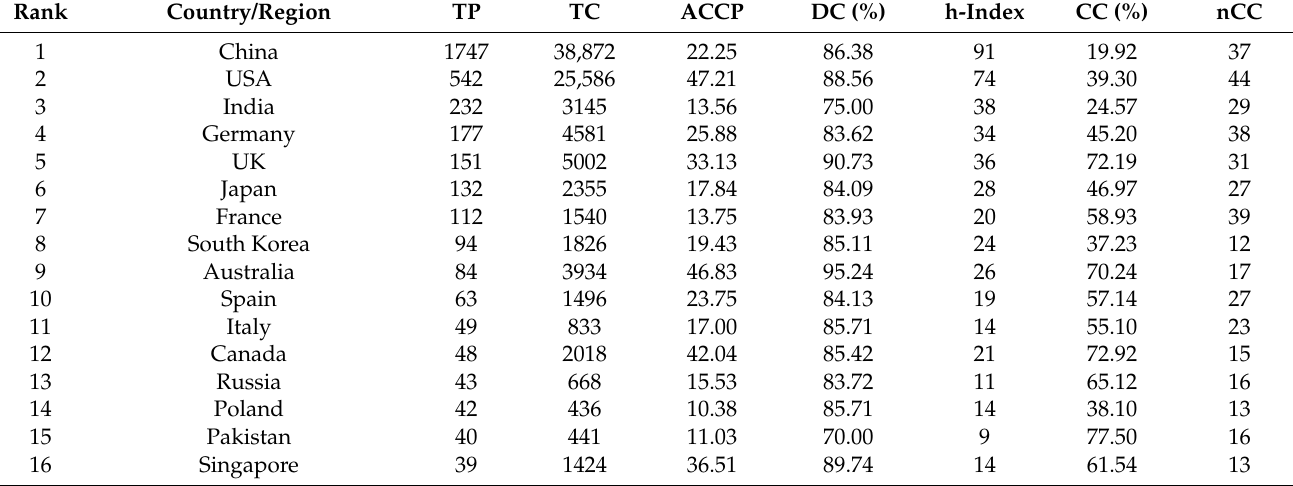
Table 1. Contribution and impact of the top 20 most productive countries/regions in energy storage ceramics research.